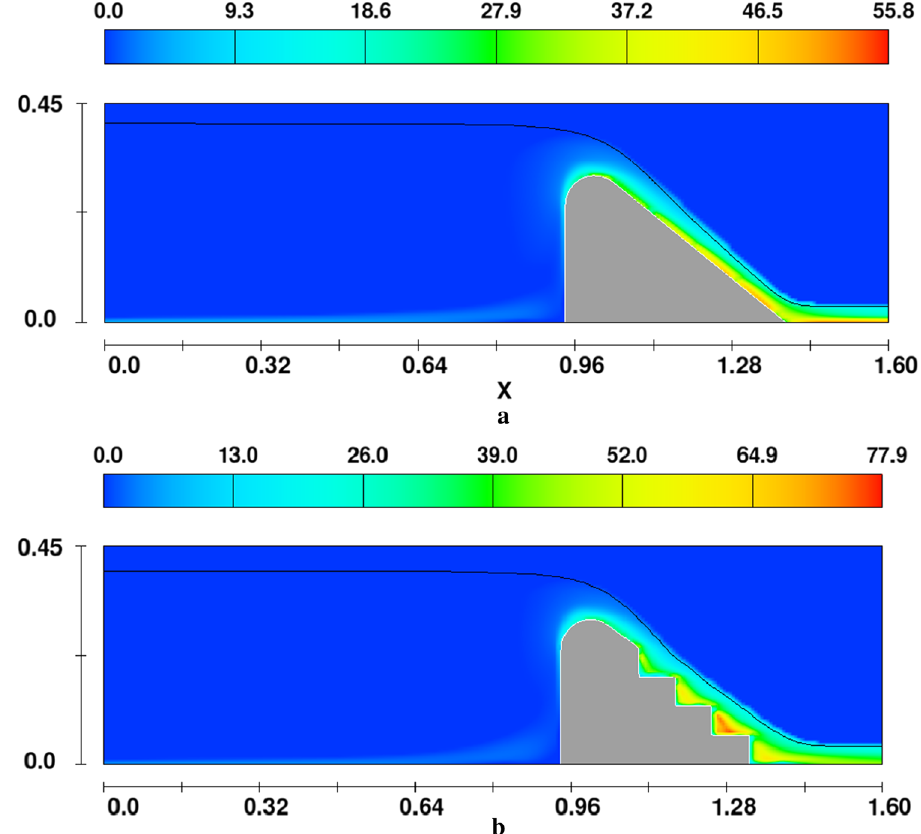
Fig. 9 The distribution of tur- bulent intensity percentage over the smooth ( a ) and CCSS ( b